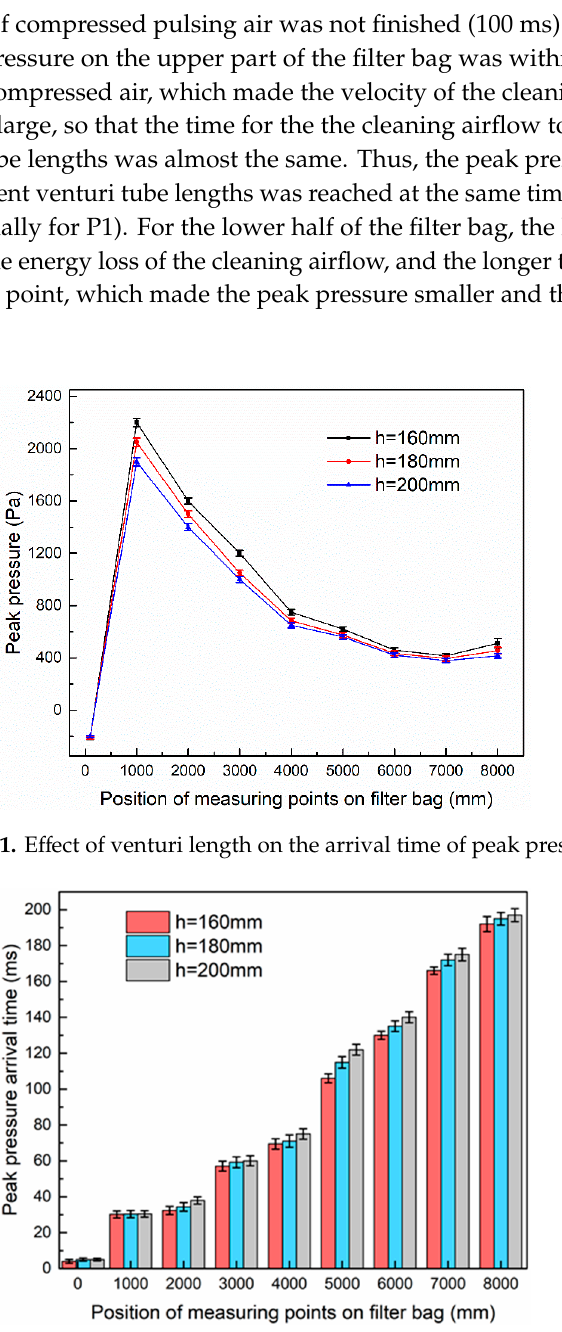
Figure 12. Effect of venturi length on peak pressure arrival time.